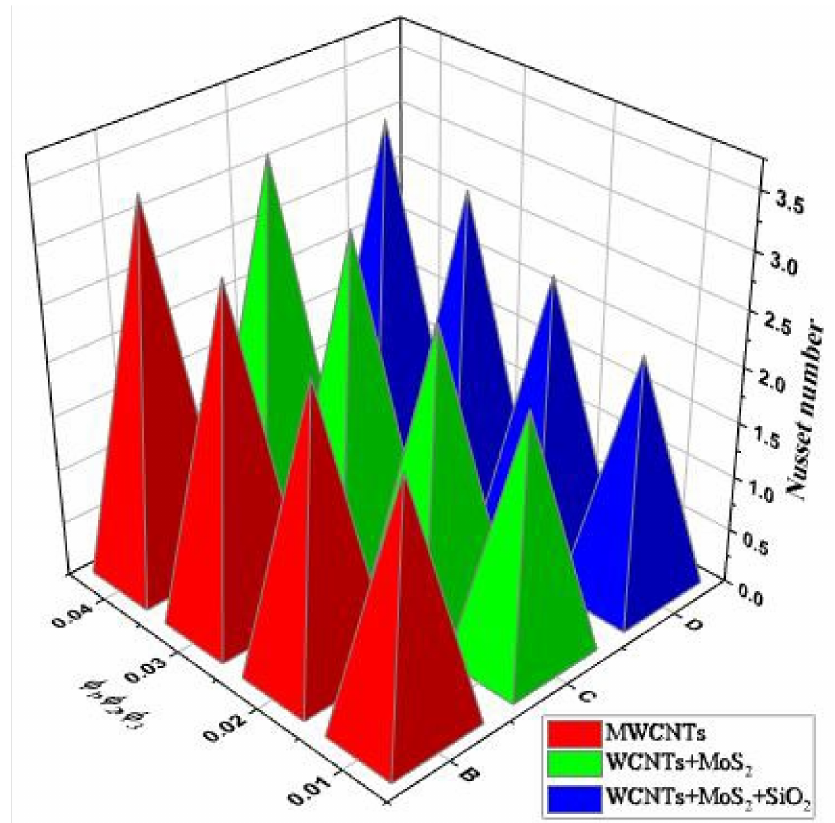
Figure 12. Nusselt number vs. φ 1 , φ 2 , φ 3